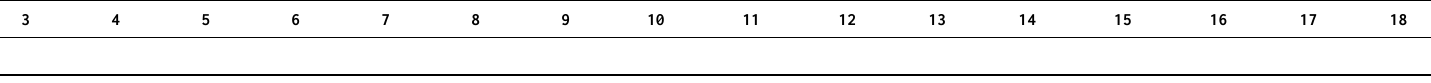
Table 3. Spearman’s rank correlation